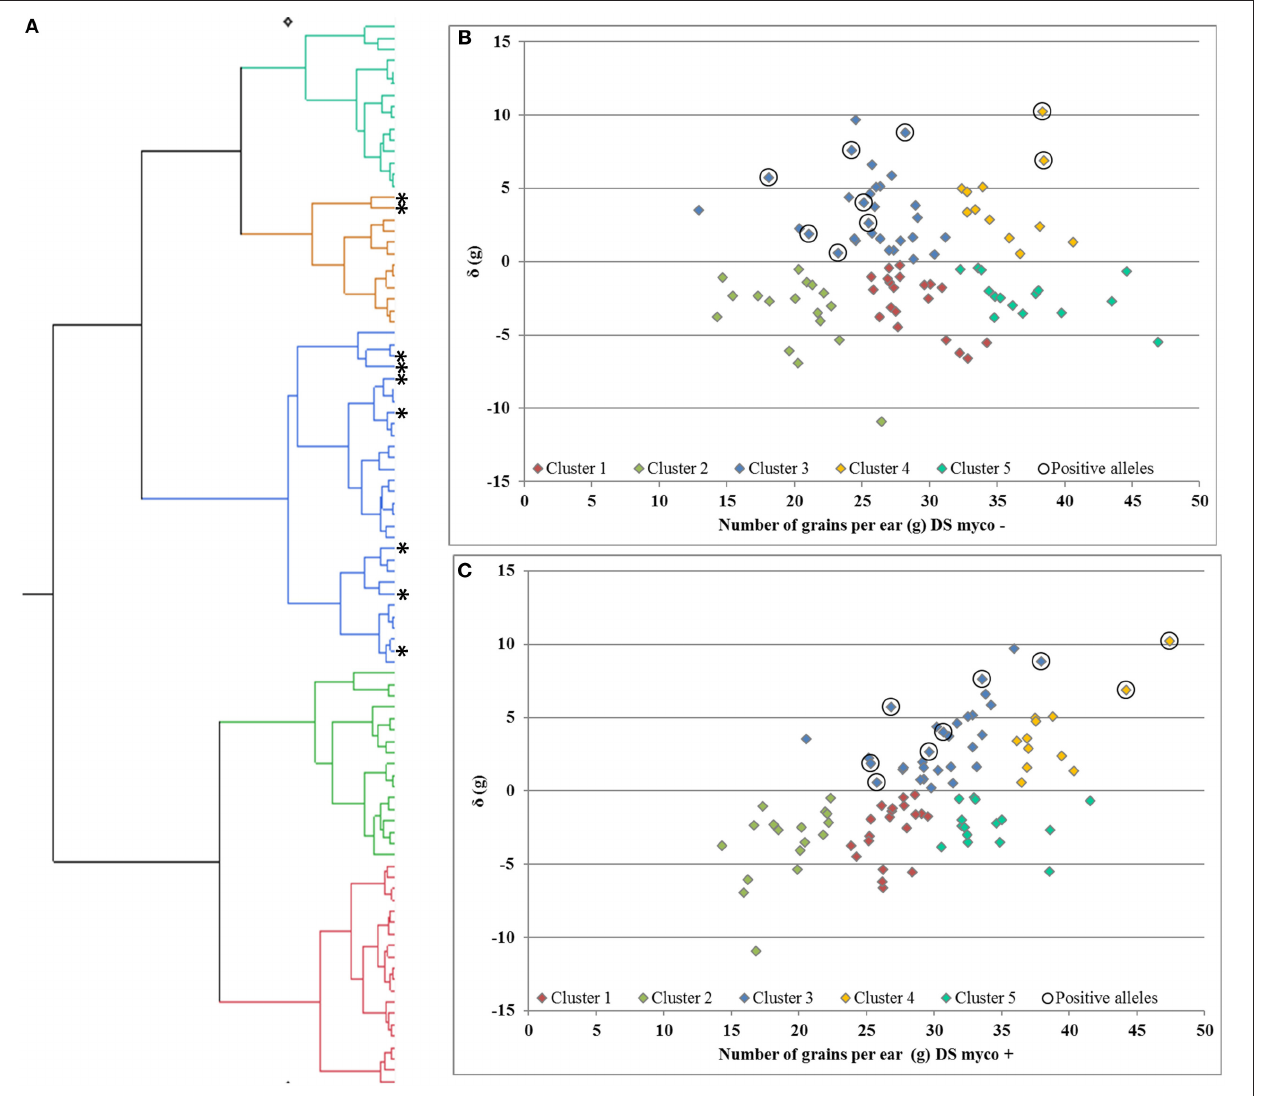
FIGURE 6 | (A) Hierarchical cluster analysis and residual ( δ ) plots for regression of number of grains per ear under drought stress in the presence of mycorrhizae against number of grains per ear under drought stress in the (B) absence and (C) presence of mycorrhizae. Genotypes carries alleles positive associated with response to mycorrhizae highlighted by *and 0,